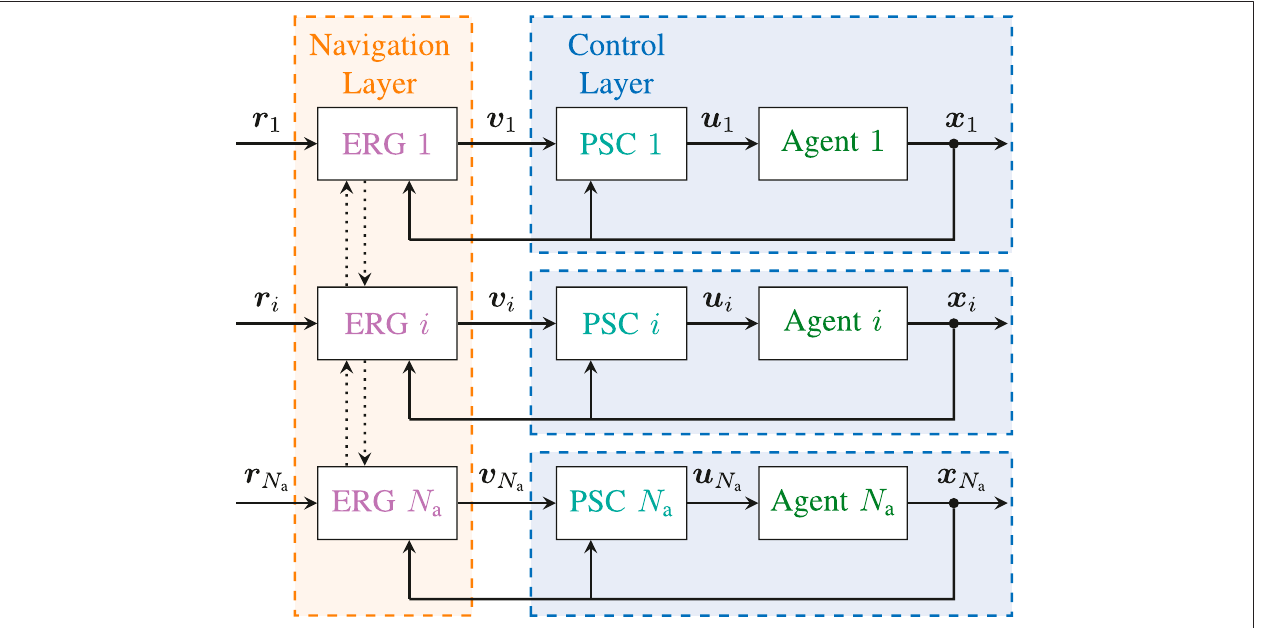
FIGURE 2 | Distributed Constrained Control Architecture − The higher-order dynamics of each agent in the multi-robot system are stabilized by a Pre-Stabilizing Control (PSC) unit that computes the control inputs u i using only x i for state feedback and without accounting for constraints. An Explicit Reference Governor (ERG) block is placed in a distributed fashion before each pre-stabilized agent and only relies on information v N enforce state and input constraints and achieveasymptotic convergence to r i . In this article v N or theset ofstates x k inthedecentralizedpolicy(suchthataworst-case approximationof v k canbelocally computed) forallagents k intheone-hop localneighborhood of agent i . We assume each agent can communicate in parallel with its neighbors.